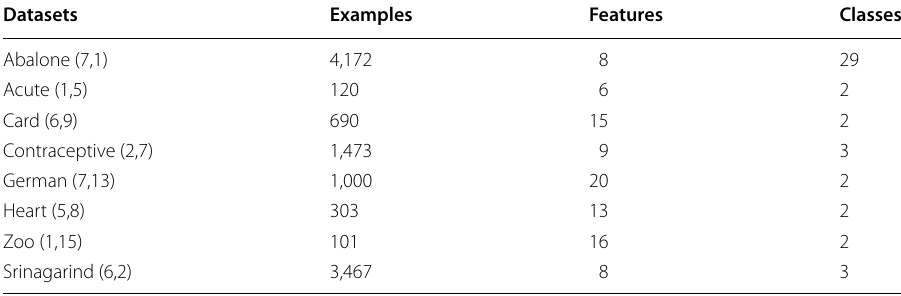
Table 3 Basic information on the mixed